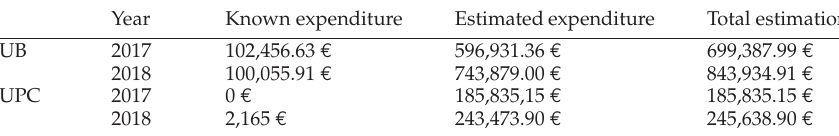
Table 9: Total estimation of the payments made at the UB and the UPC for publishing in open